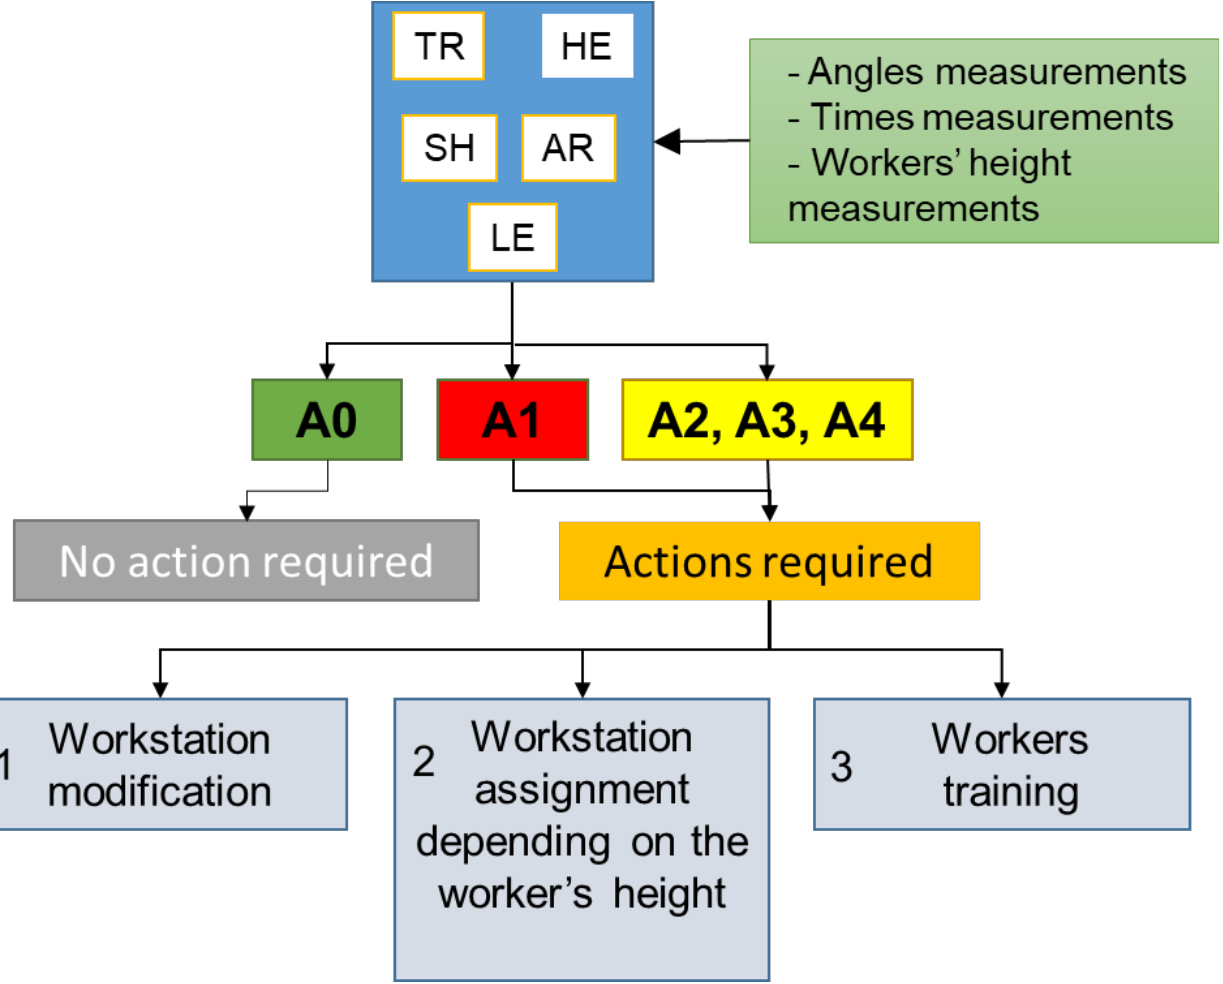
Figure 14. Case study output: detail of the ergonomic assessment parameters and posture risk re- duction.